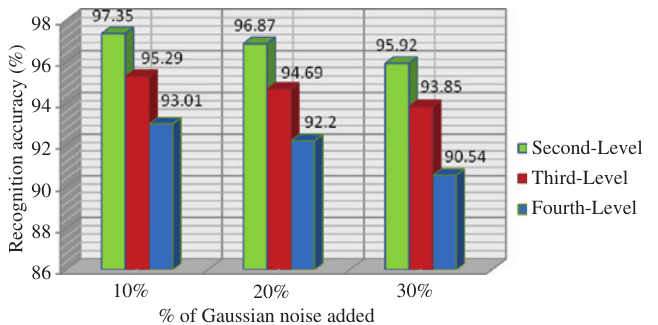
Figure 7: Comparison of the Impact of Added Gaussian Noise to Handwritten Script Identification Accuracies (Evaluated Using the SVM Classifier) at All Three Levels of Page